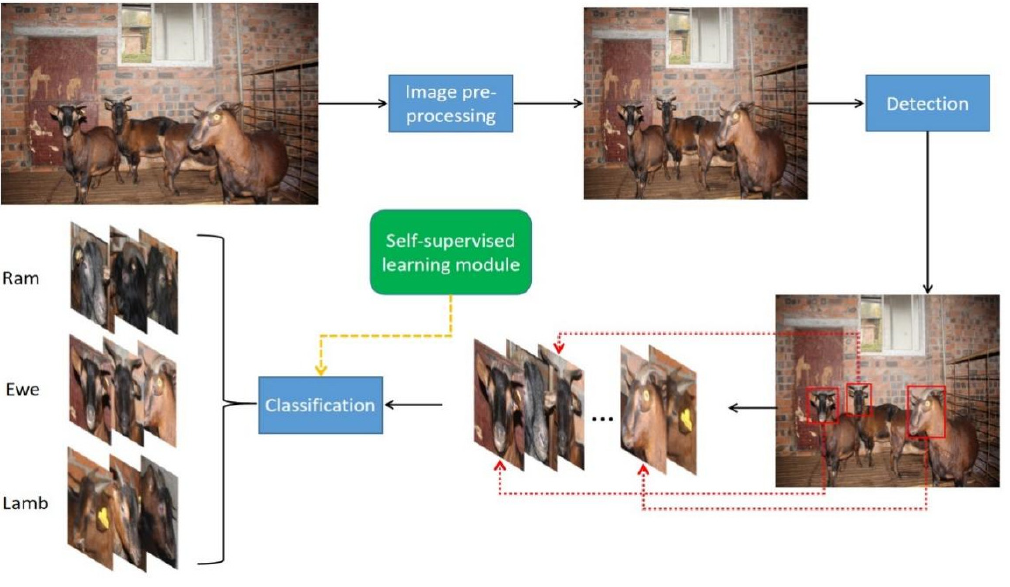
Figure 1. The overall pipeline of our framework. After preprocessing the images, the heads of Chengdu ma goats are detected using our improved object detection network. Since the classification effect of the detection network is not satisfactory, we construct a classifier incorporating a self- supervised module to accurately classify the detected heads.